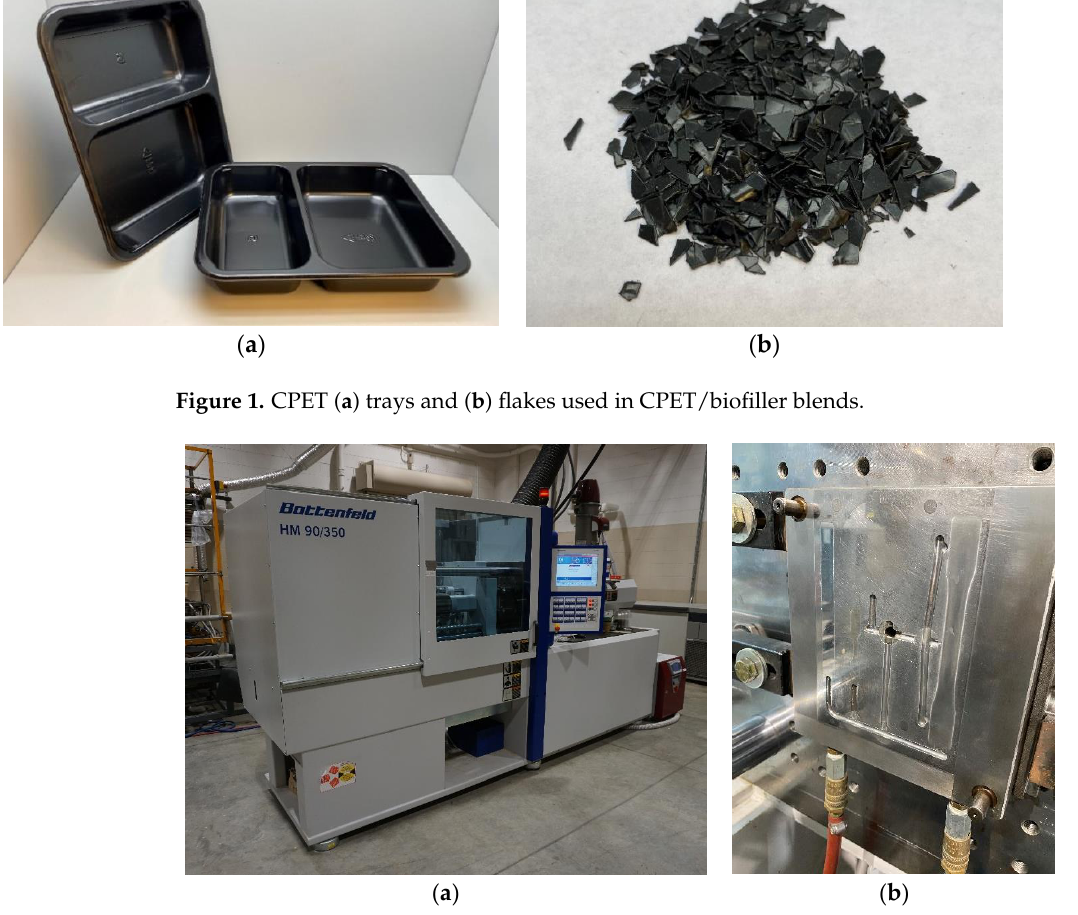
Figure 2. ( a ) Injection molder and ( b ) mold setup used in the production of Type I Dog Bone. Table 1. CPET/biofiller blends formulation in terms of weight percentage.